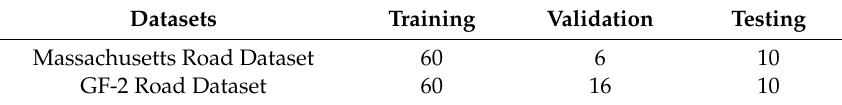
Table 4. An overview of the